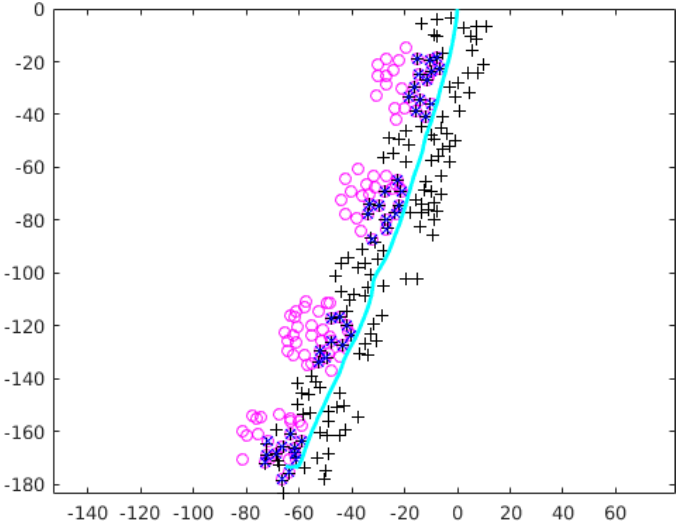
Figure 18. Malmköping 2. Map over detected trees (black ‘+’), field measured trees (magenta ‘o’) and linked trees (black ‘+’ + magenta ‘o’ + blue ‘x’). The cyan line shows the vehicle trajectory, starting in [ 0,0 ]